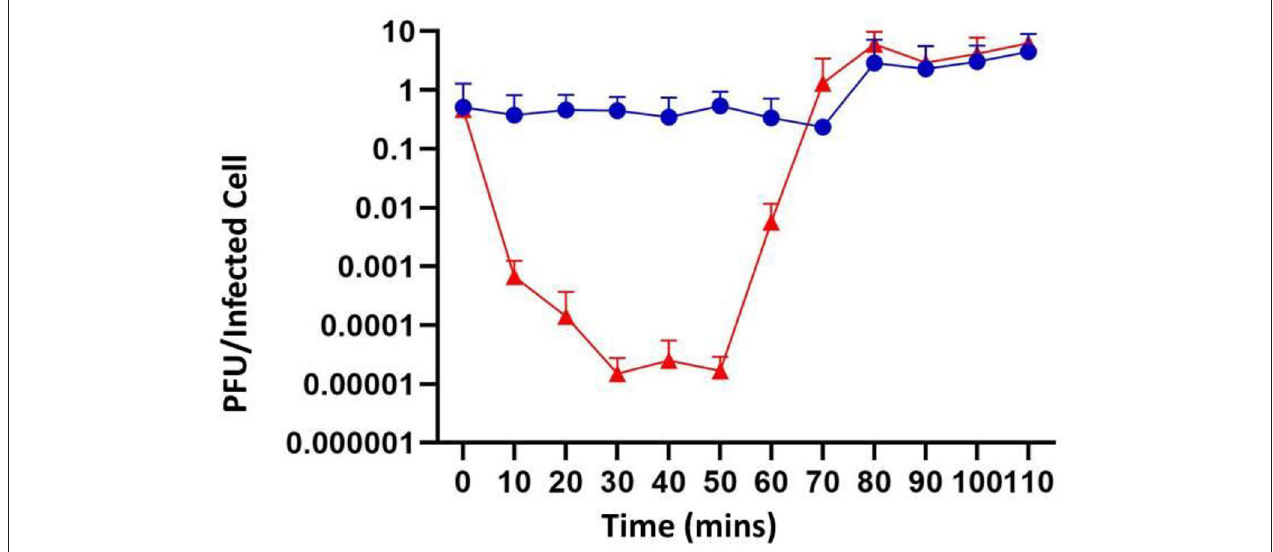
FIGURE 3 | One-step growth curve of phage P61. Blue circles represent samples that were directly plated, representing the cumulative concentration of absorbed phages and unabsorbed phages. Red triangles represent samples that were treated with chloroform prior to plating, representing the total concentration of phages including intracellular phage. All values are means of three independent experiments.